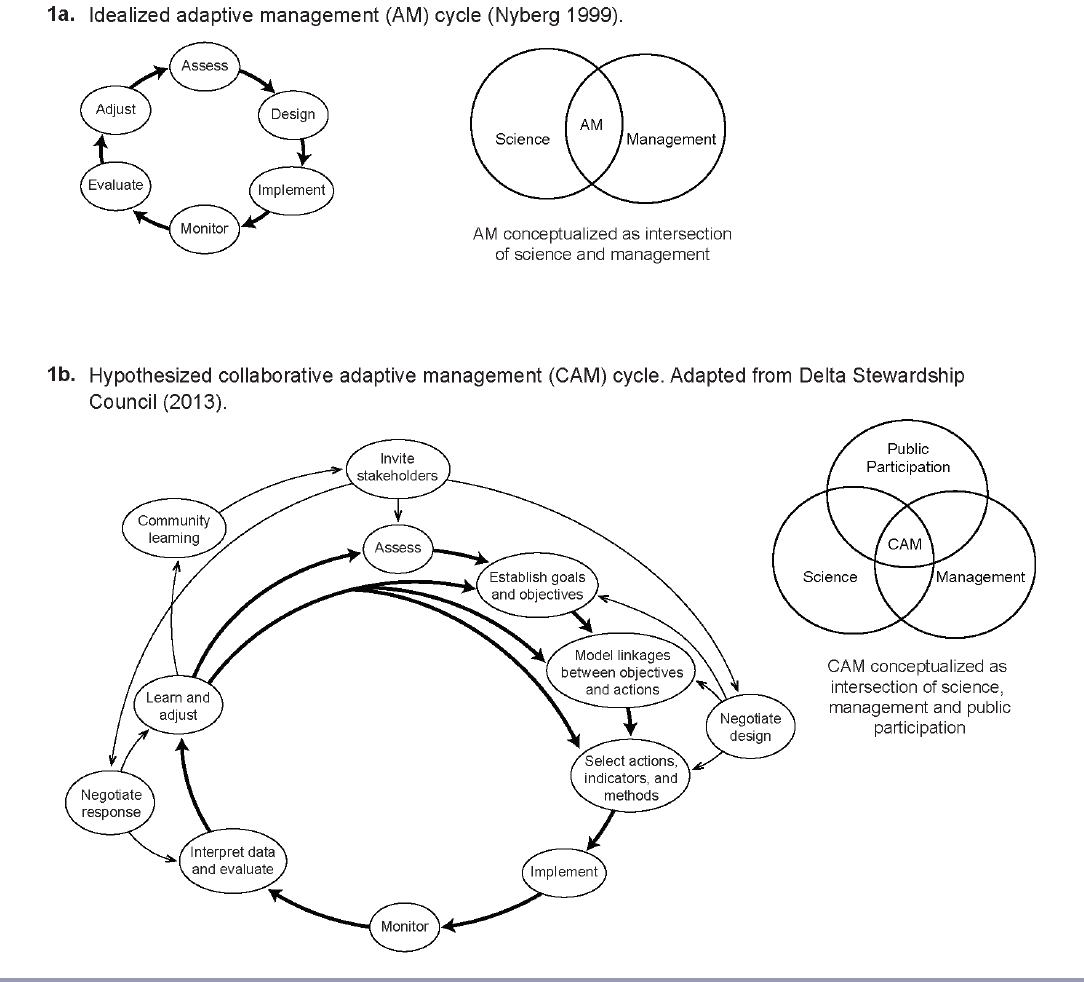
Fig. 1 . Idealized (a) adaptive management and (b) collaborative adaptive management cycles. Based on Nyberg (1999) and Delta Stewardship Council